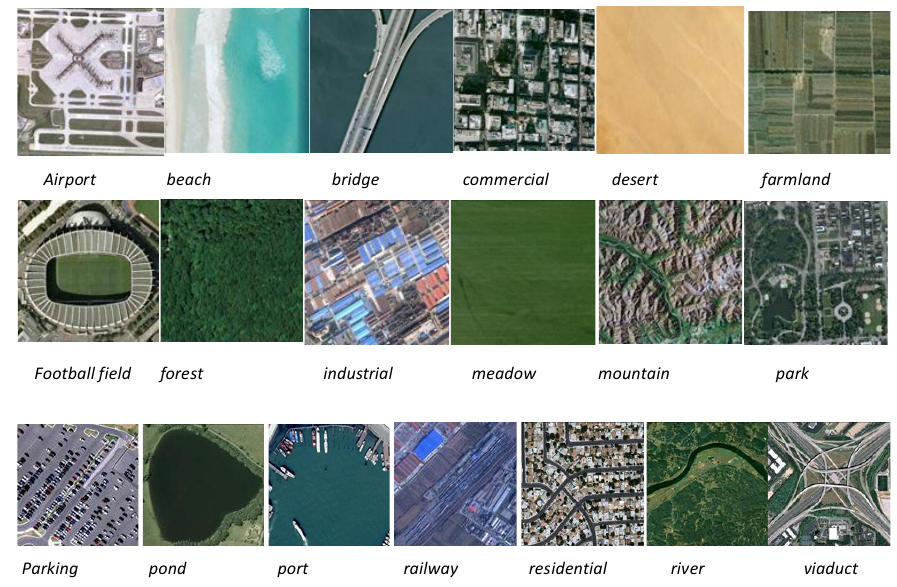
Figure 8. Examples of ground truth data in the WHU-RS dataset.